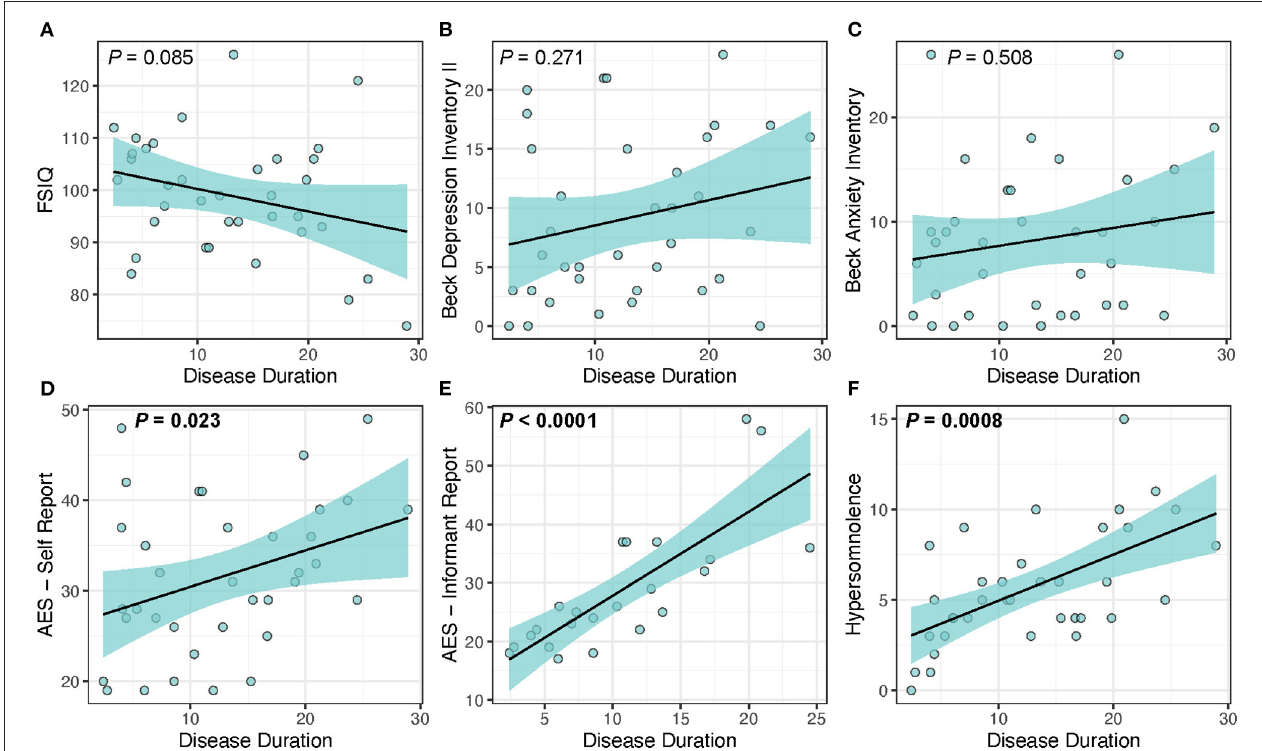
FIGURE 1 | Disease duration as a predictor of clinical measures in DM1. Disease duration was not associated with changes in (A) FSIQ ( P = 0.085), (B) depression ( P = 0.271), or (C) anxiety ( P = 0.508), but was significantly associated with increased scores for the core symptoms of (D ) self-reported apathy ( P = 0.023), (E) informant reported-apathy ( P < 0.0001), and (F) hypersomnolence ( P = 0.0008). Light-blue shaded region represents 95% confidence